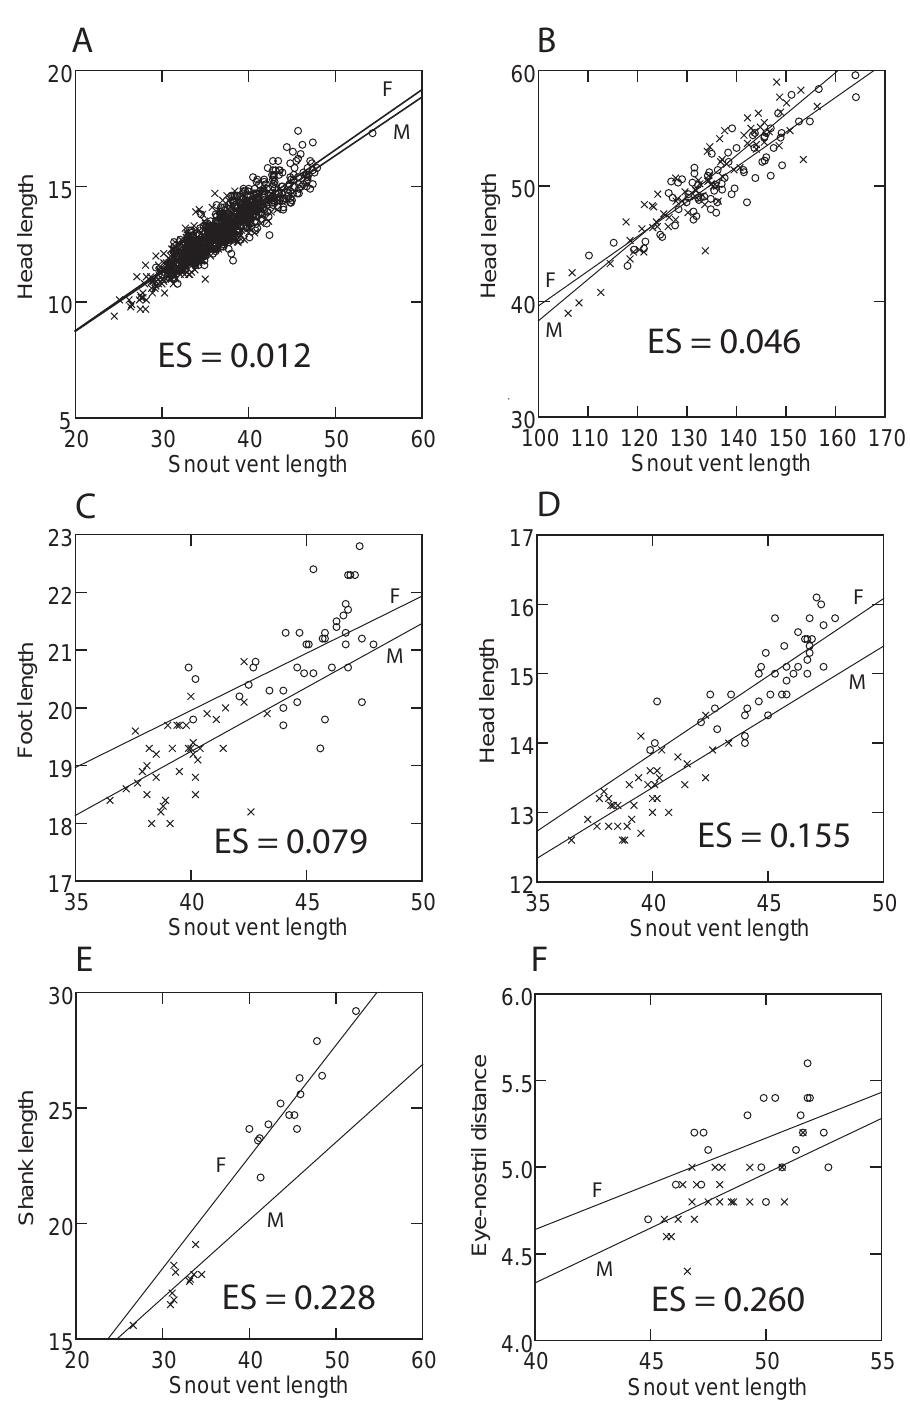
Fig. 7 – Scatterplots of variables with different effect sizes (ES). A = Leptodactylus podicipinus (all data), B = Middle American pentadactylus, C and D = L. podicipinus –Alejandra, Bolivia sample; E = Eleutherodactylus fenestratus , F = L. troglodytes . F (within figures) = female data regression line, M = male data regression line. All values in